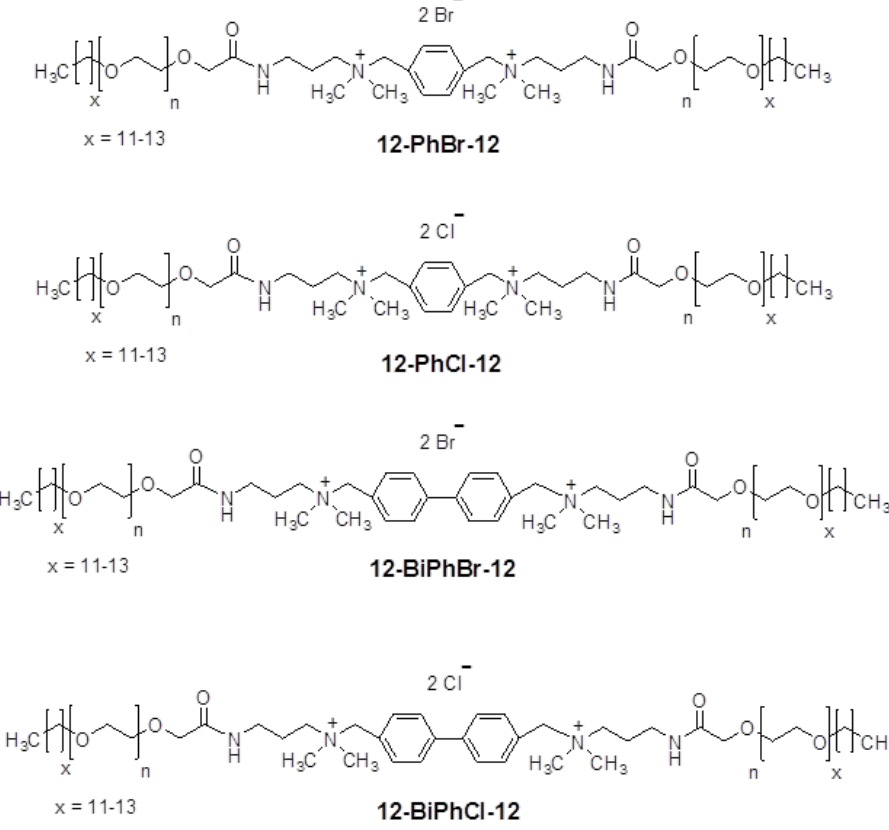
Figure 1. Chemical structure of synthesized surfactants.